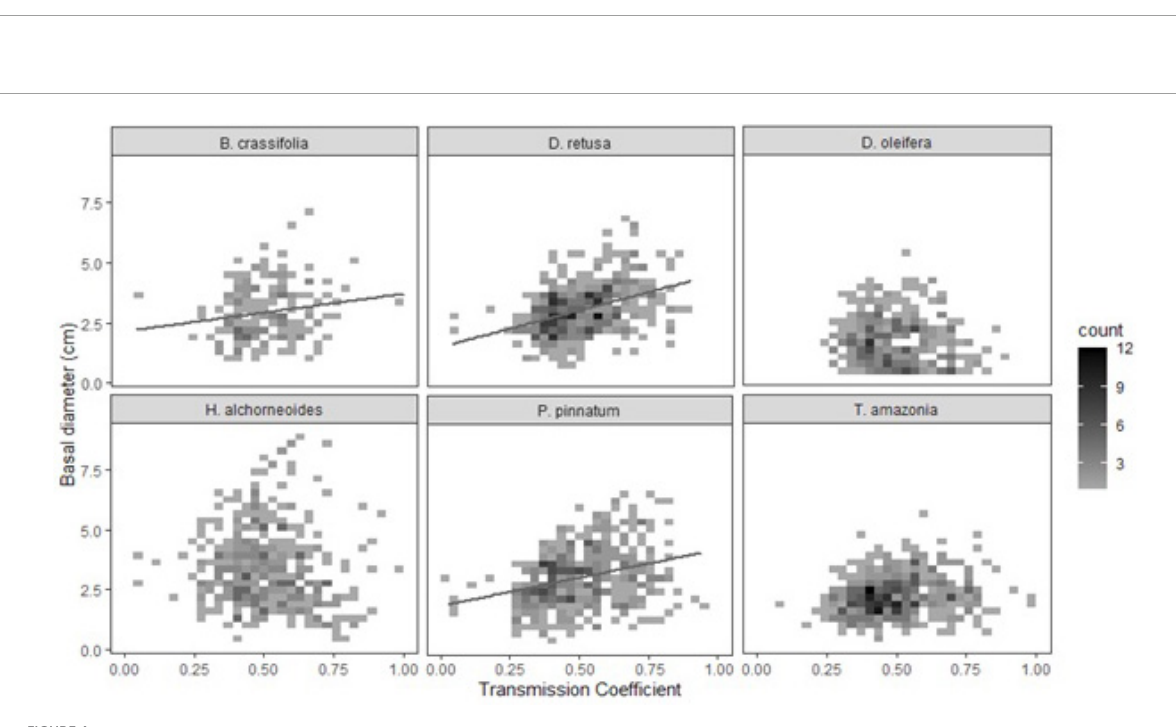
FIGURE4 Effect of light availability (transmission coefficient) on seedling growth (30-month basal diameter, cm). Due to a large number of observations, data are presented as binned counts: graph area was divided into x,y grid cells (30 × 30 rectangles). Shading of each grid cell represents the number of individual seedlings ( n = 1–12) with values of light availability and growth that fall within that cell; lighter shading denotes fewer seedlings and dark shading denotes a higher number of seedlings. Light availability was significantly related to growth of B. crassifolia, D. retusa, and P. pinnatum but not the other three